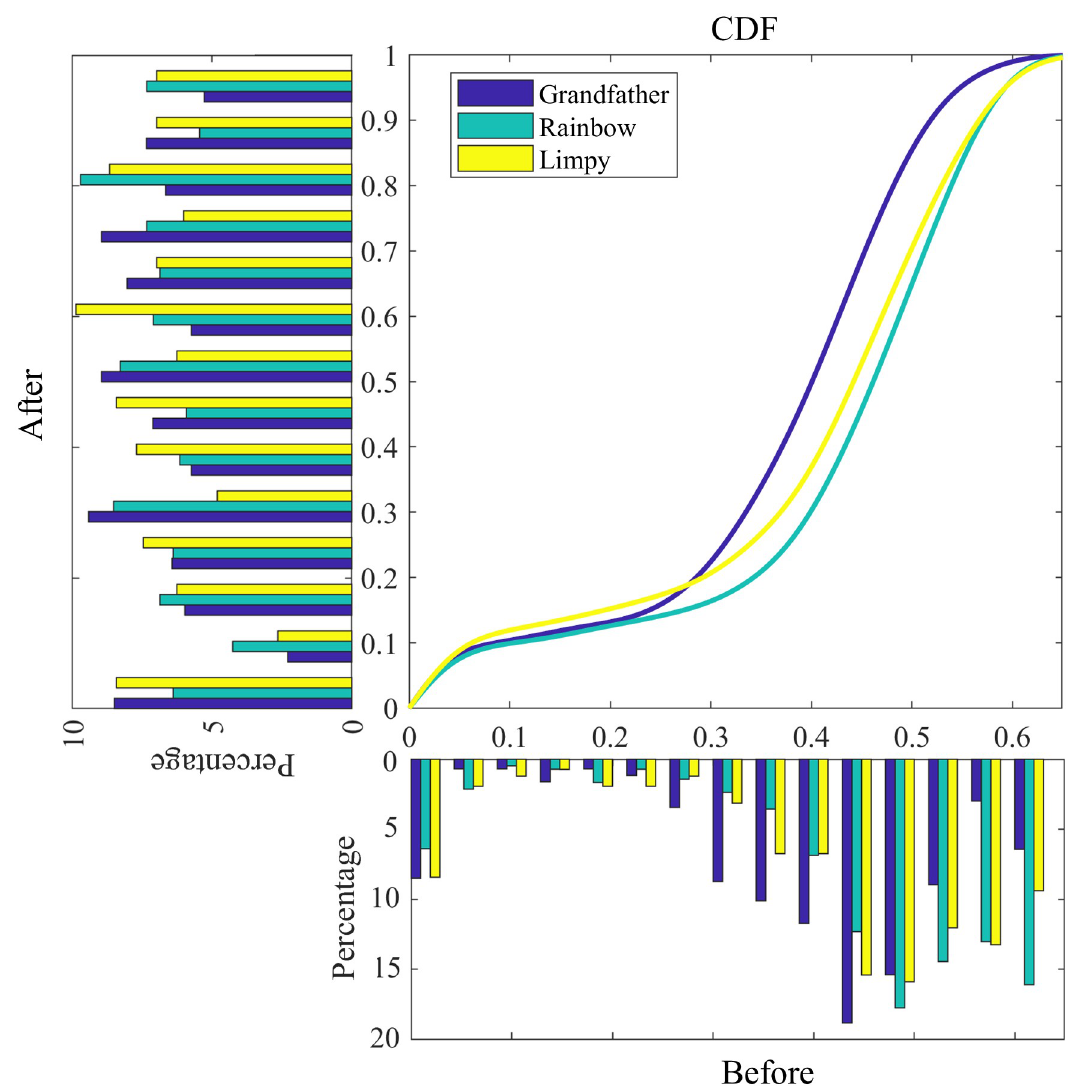
Fig 12. An illustration of score normalization based on a cumulative distribution function, for the story recall task. Bottom: distribution of the original scores (ROUGE-1); Center: cumulative distribution functions; Left: distribution of the normalized scores.